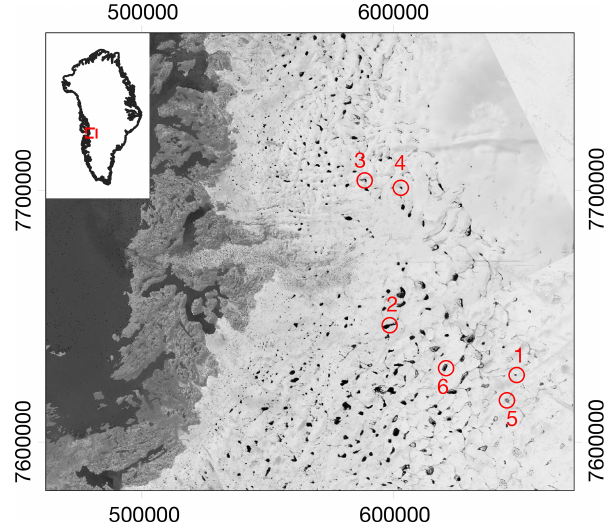
Figure 1. Study area within the context of the Greenland Ice Sheet (inset). Distribution of all surface lakes detected from optical im- agery, with the six winter draining lakes highlighted (red numbers, in chronological order of drainage), which are shown in more detail in Fig. 6. The base map is a composite image showing the maxi- mum NDWI ice observed for each pixel in Landsat 8 optical images over the course of all summers from 2014 to 2017. The outline of Greenland is from OpenStreetMap (© OpenStreetMap contributors 2019; distributed under a Creative Commons BY-SA